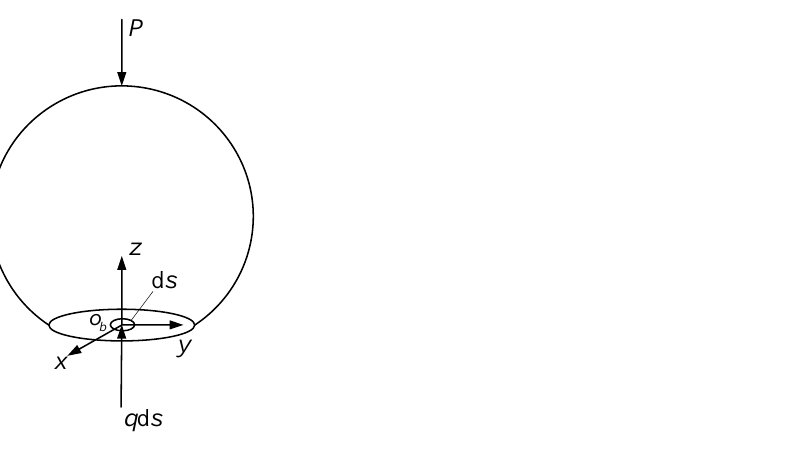
Figure 3. Force element qds acting normal to the circular contact area of the sphere.